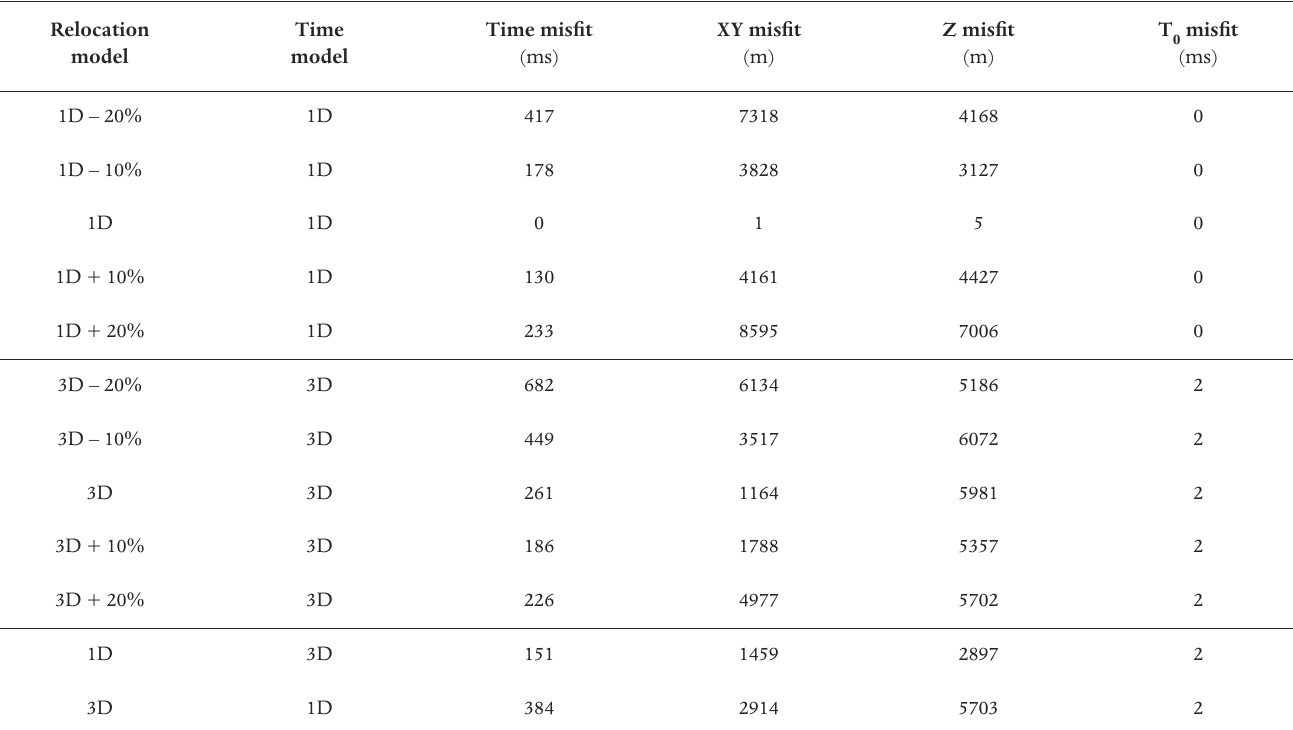
Table 3. Absolute average root mean square time and coordinate misfit for the different combinations of 1D and 3D travel-times and relocation models. The 'Time misfit' column shows the average squared differences between the 'known' (synthetic) and the estimated travel-times, the 'XY misfit' and 'Z misfit' are the average squared differences between the actual and estimated hypocentral coordinates, and the 'T estimated time